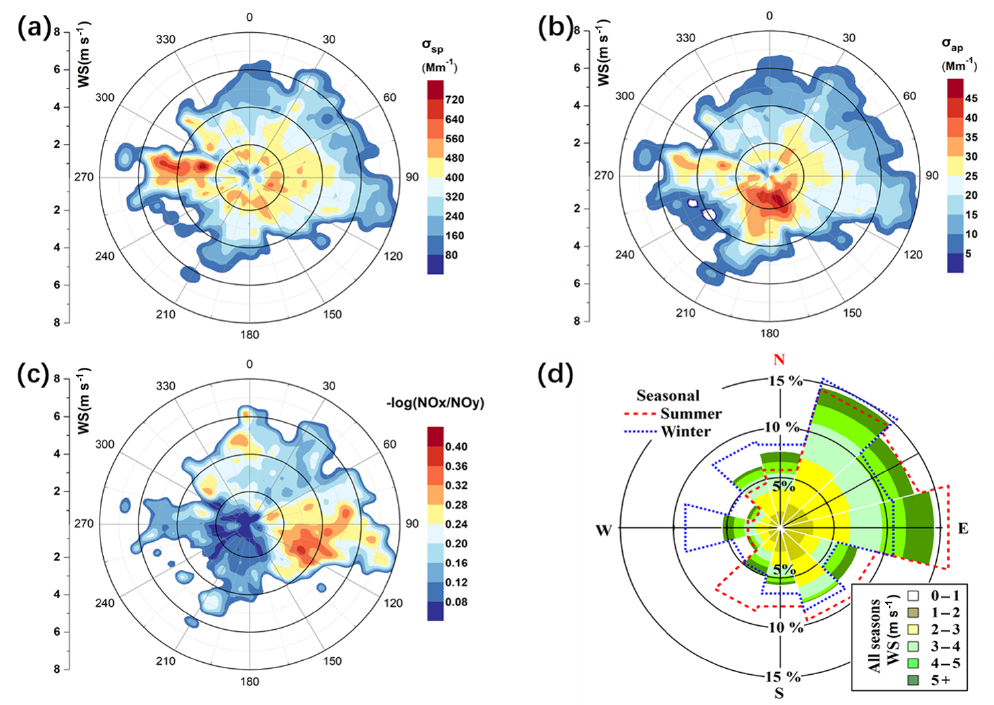
Figure 6. Contour polar plots of (a) scattering coefficient at 525nm, (b) absorption coefficient at 520nm, (c) photochemical age =− log (NO x /NO y ) , and (d) a standard wind rose for 2